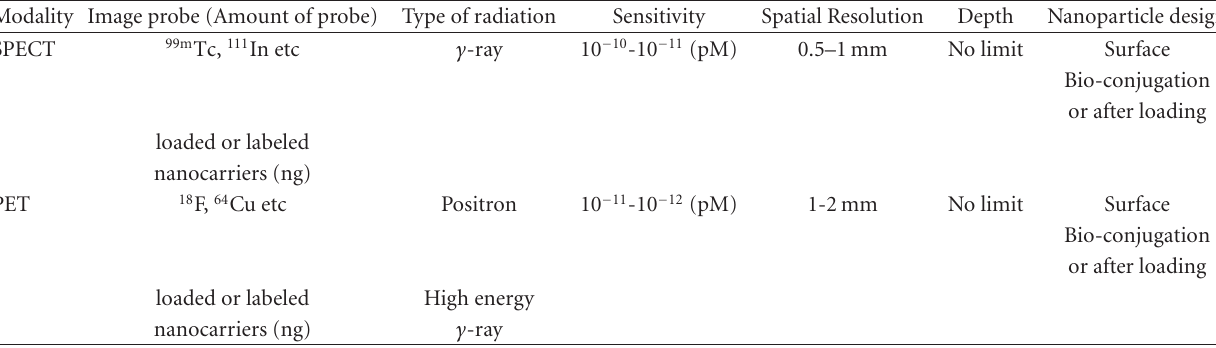
Table 3: Characteristics of nanotargeted nuclear imaging modalities [20,